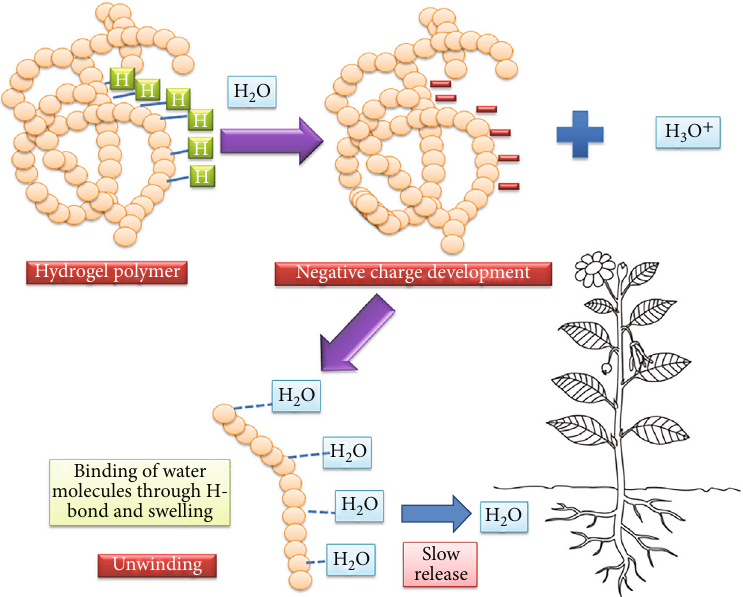
Figure 1: Mechanism of action of hydrogel upon soil-based